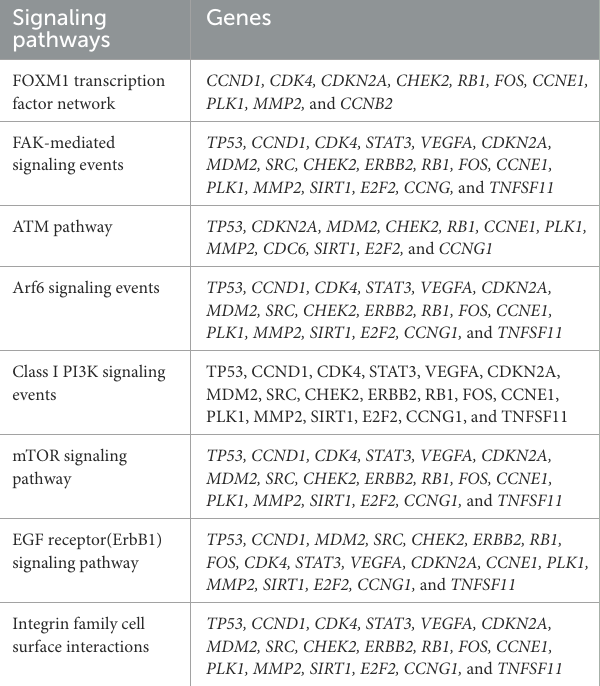
TABLE 2 List of Osteosarcoma related genes and their associated signaling pathways. Signaling